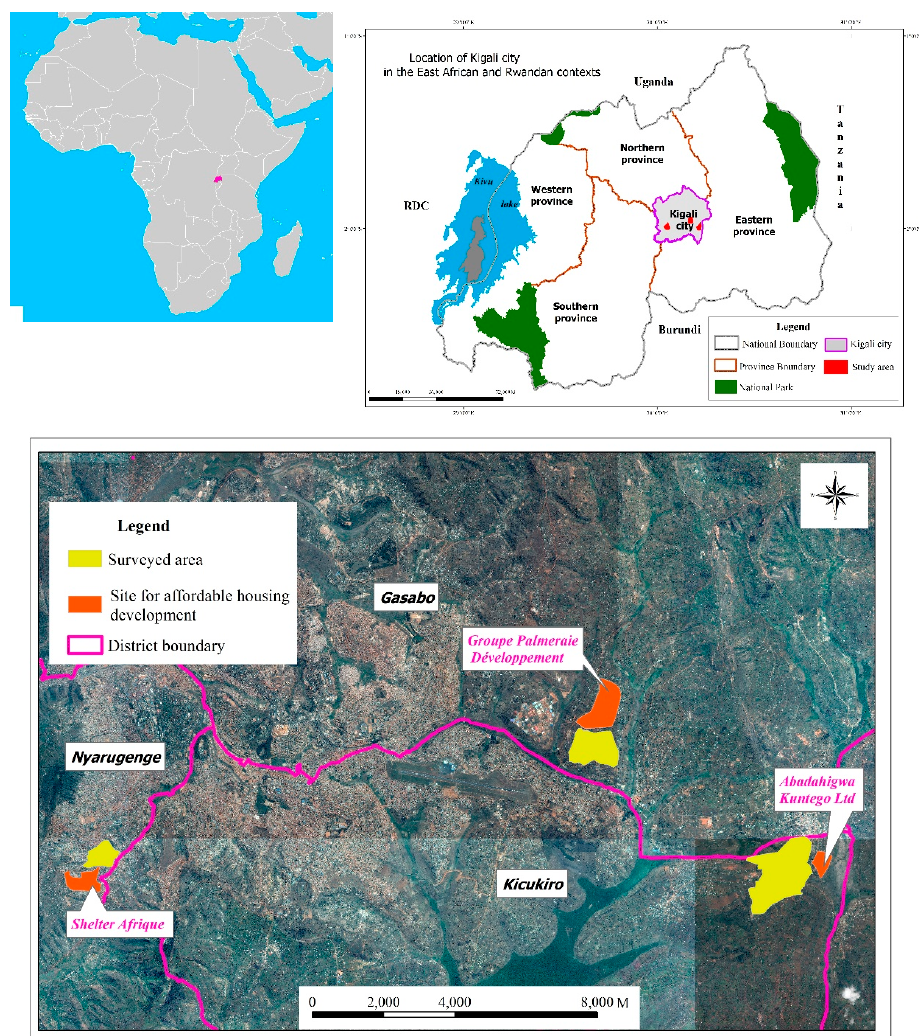
Figure 1. Location of the study area. Data source: Field survey, July to September 2018 and January to March 2019, and proposals for housing development projects approved by Rwanda Housing Authority (RHA).